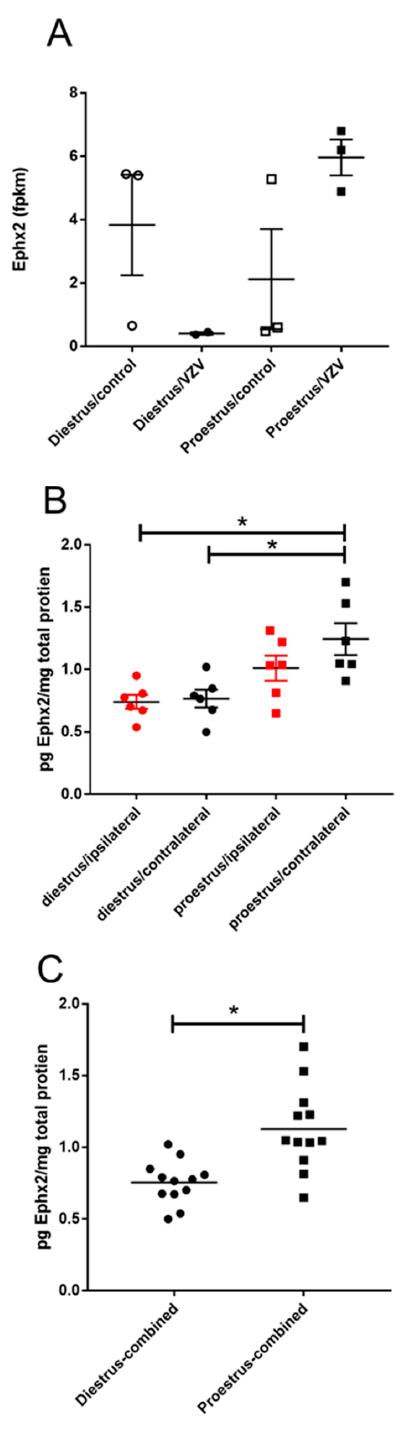
Figure 4. Expression of epoxide hydroxylase 2 (Ephx2) significantly increased in the parabrachial region during proestrus. Rats were injected with varicella zoster virus in the left whisker pad to induce orofacial pain. Parabrachial brain tissue was collected from these female rats during the proestrus and diestrus phase of the estrous cycle. This tissue was analyzed for RNA (panel A ) and protein (panels B , C ). In panel ( B ) the right (contralateral to VZV injection) and left (ipsilateral to VZV injection) side of the brain was analyzed separately and in panel ( C ) the protein content from both sides of the brain were combined. Fragments Per Kilobase of transcript per Million mapped reads (fpkm). The asterisk indicates a significant di ff erence between groups p <